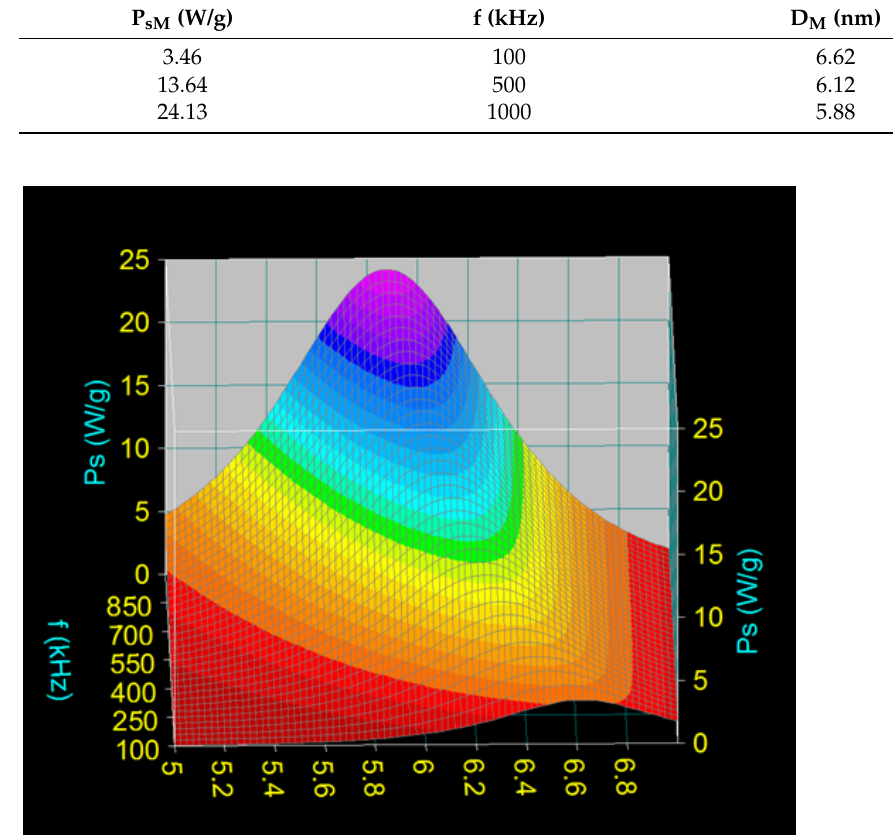
Figure 2. The variation of the position of maximum specific loss power (P sM ) with the frequency of magnetic field (f) and diameter of CoFe 2 O 4 nanoparticles (D) in nanometers range.